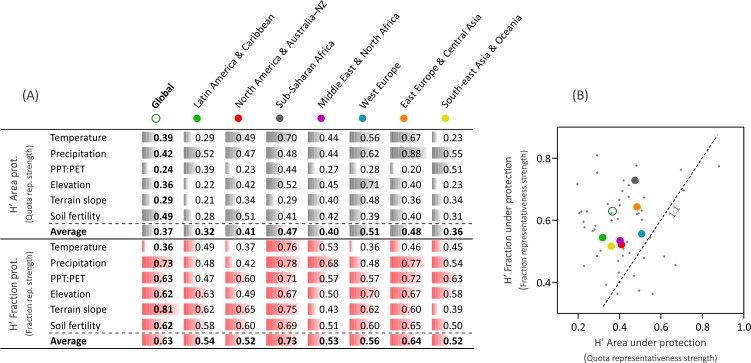
Representativeness according to a modified Shannon evenness.Modified Shannon evenness (H′) for the biophysical variables. The index ranges between 0 and 1, with a value of 1 when xij is constant along the i gradient. (A) H′ values of the area under protection (in light gray), related to the “quota representativeness” motivation; and H′ values of the fraction under protection (in red), related to the “fraction representativeness”. (B) plot of all H’ values of the 48 biophysical variables * globe/regions combinations (small gray dots), and averaged H′ values for the globe and the seven regions (large colored dots).